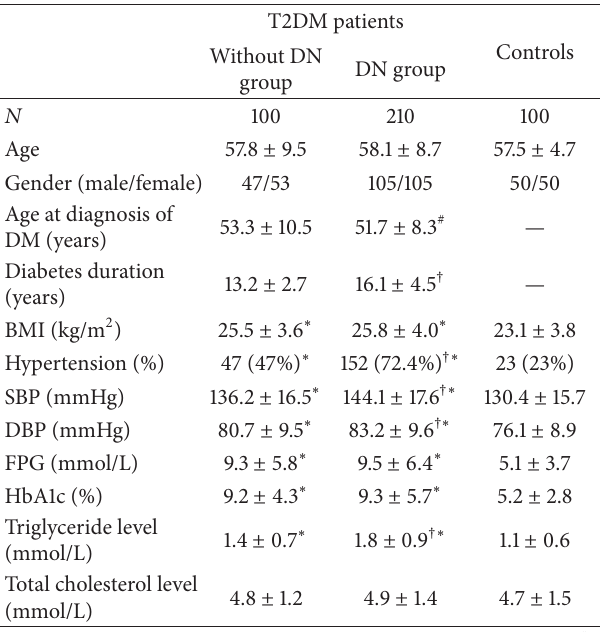
Table 1: Clinical and biochemical parameters of the controls and diabetic